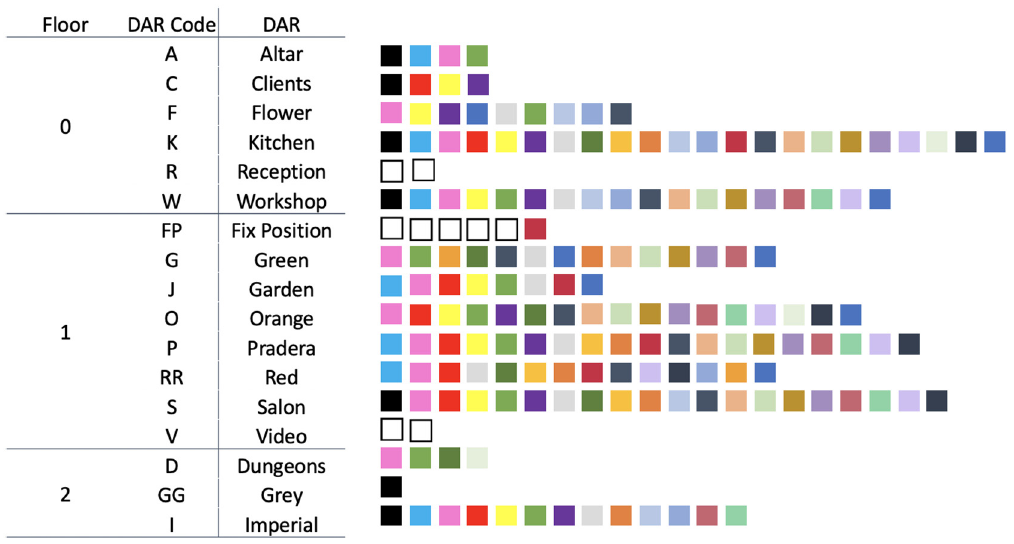
Figure 11. Space popularity graph (each color represents an anonymized